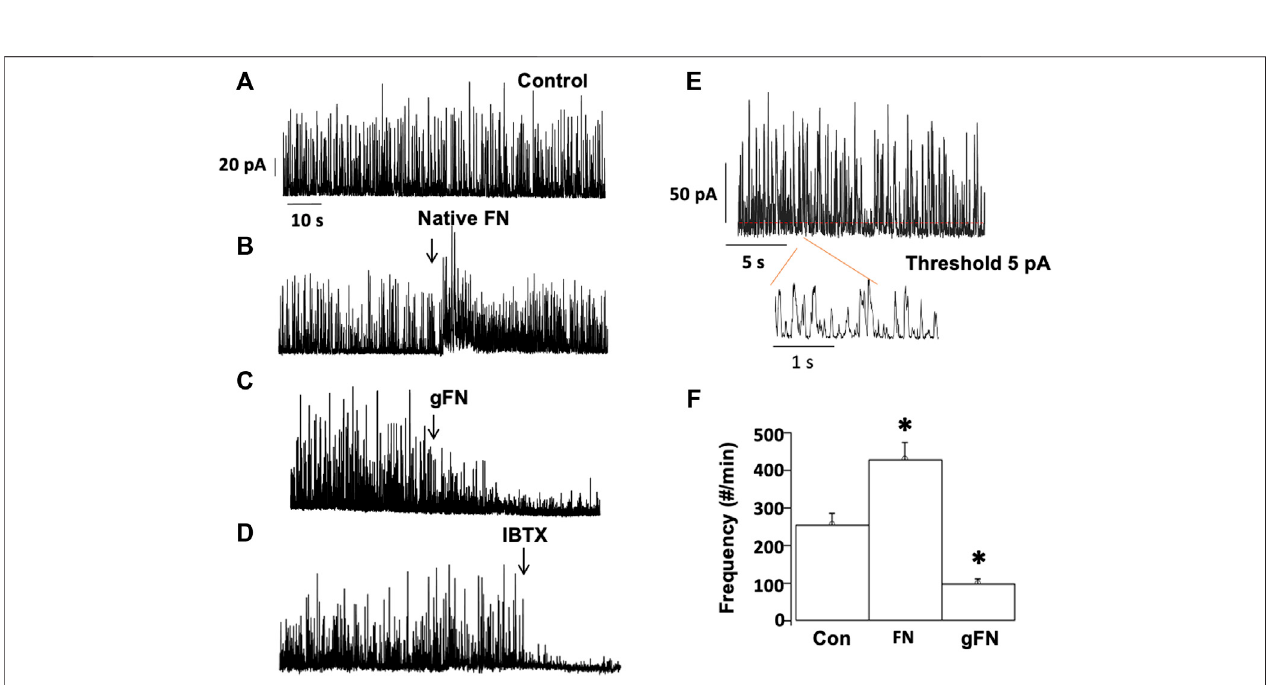
FIGURE4| gFNdecreasesthefrequencyofSTOCsinisolatedcerebralvascularSMCs.Outwardcurrents (A) werestimulatedbynative fi bronectin (B) ,whilebeing attenuatedbyglycated fi bronectin(gFN) (C) .STOCactivity, dependentonBK Ca channelopening,wasinhibited byiberiotoxin(IBTX,0.1 μ M; (D) .Panel (E) illustratesthe analytical method for quanti fi cation ofSTOC frequency and group dataare shown in panel (F) .Recordings were made at aholding potentialof+30 mV, n =10 – 16cells. The bar graph is presented as mean ± SEM; * p < 0.05 vs control.